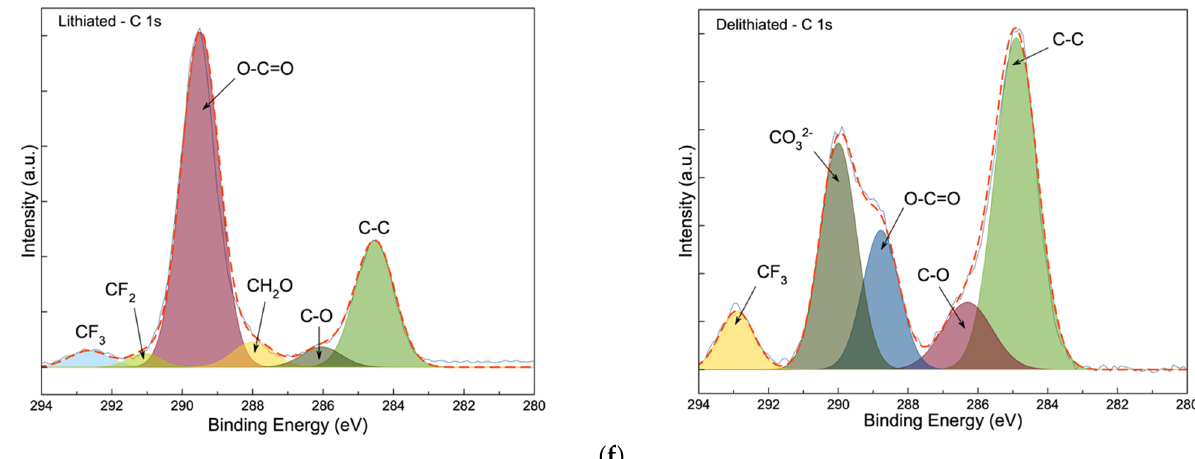
Figure 15. XPS spectra of ( a ) Si 2p, ( b ) N 1s, ( c ) Li 1s, ( d ) F 1s, ( e ) O 1s, and ( f ) C 1s at the surface of the Si 3 N 4 @Si@Cu anode during two stages: lithiated and delithiated (left to right).